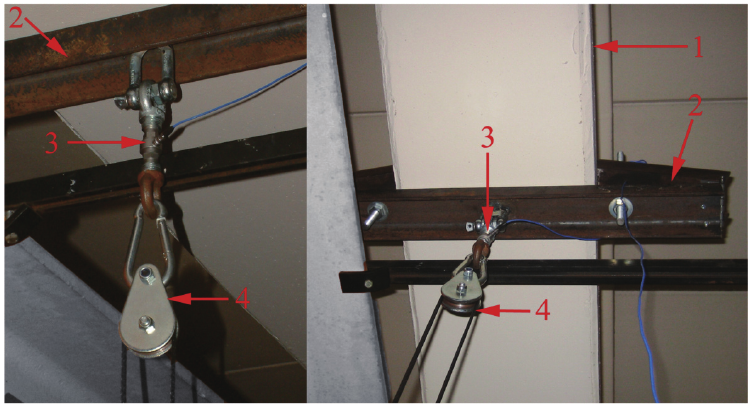
Fig. 4. Position of the force sensor and connection of the DMSP20 to the joist structure of the ceiling. 1: Joist of the ceiling, 2: Clamping mechanism, 3: Force cell, 4: Pulley connection with the kevlar